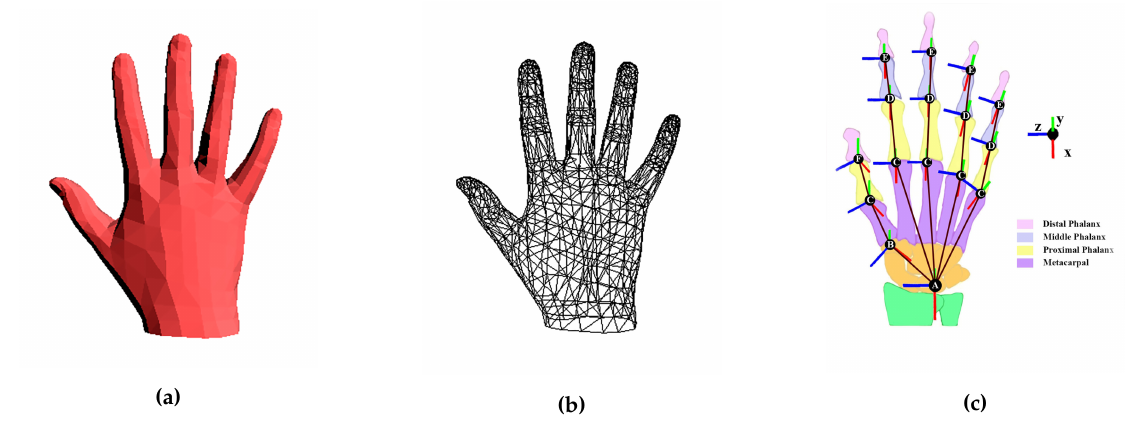
Figure 3. The MANO hand model and the kinematic chain. ( a ) The MANO hand model. ( b ) The triangular mesh of MANO. ( c ) The kinematic chain and human hand anatomy. The explanations of capital letters in ( c ) : A represents the Wrist joint. B represents the Carpometacarpal (CMC) joint. C represents the Metacarpophalangeal (MCP) joints. D represents the Proximal Interphalangeal (PIP) joints. E represents the Distal Interphalangeal (DIP) joints. F represents the Interphalangeal (IP) joint.